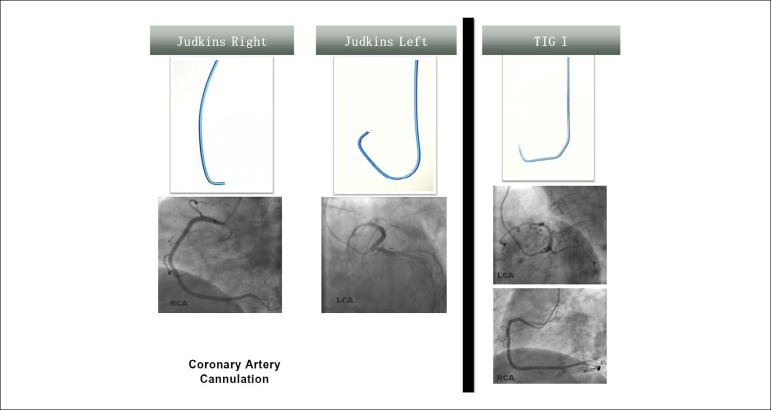
Design of TIG I and Judkins catheters and cannulation of the coronary arteries. RCA: right coronary artery; LCA: left coronary artery.